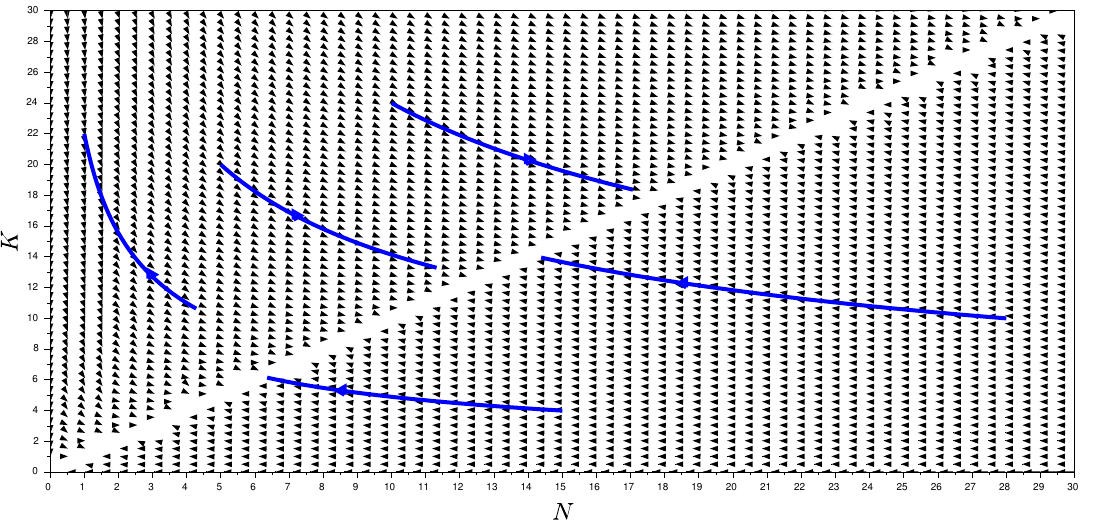
Figure 4. Representative solution trajectories of (11) in the NK -plane with θ = 1.2, a = 0.2 and b =